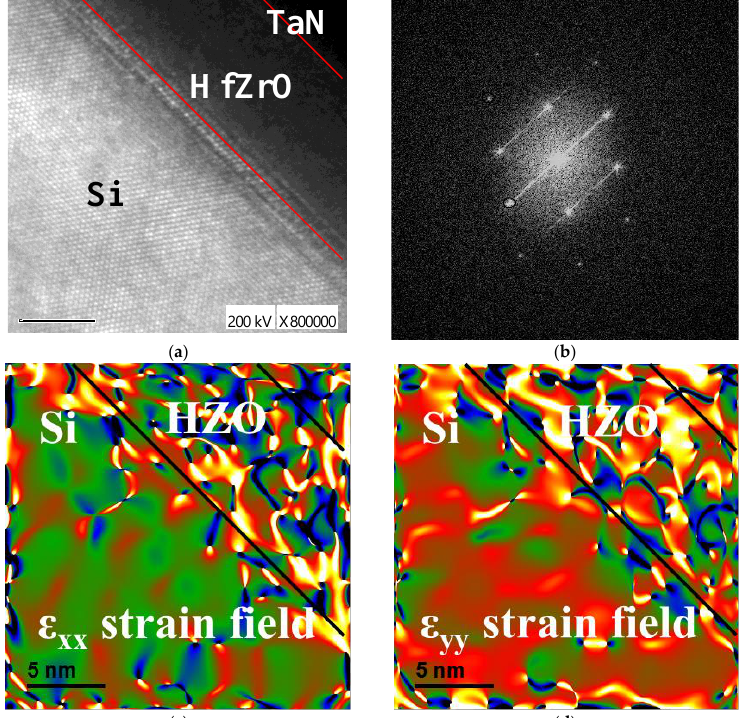
Figure 1. ( a ) TEM and ( b ) FFT images of 10-nm-thick HZO film. Simulated strain field along the ( c ) x and ( d ) y axis.